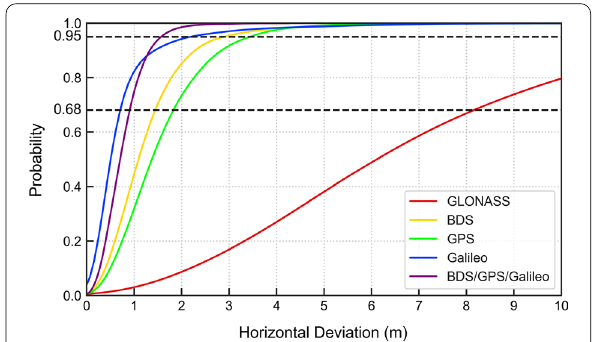
Fig. 16 Cumulative probability of smartphone horizontal position deviation based on different satellite systems